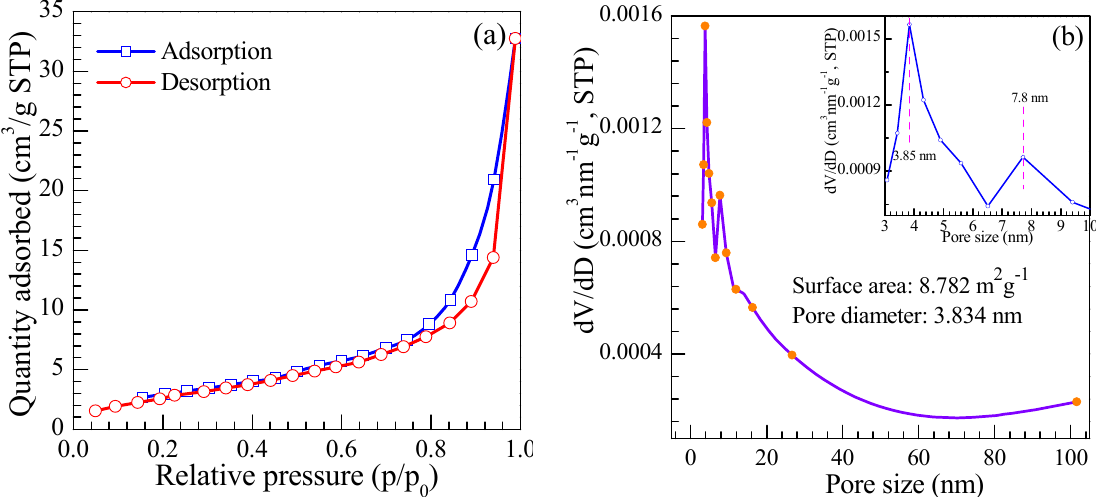
Figure 10. ( a ) Typical nitrogen adsorption-desorption isotherm; ( b ) BJH pore size distribution plots of as-prepared SnO 2 nanosheets. The inset is the enlarged pore-size distribution calculated by the BJH approach from the desorption branch of the SnO 2 nanosheets.